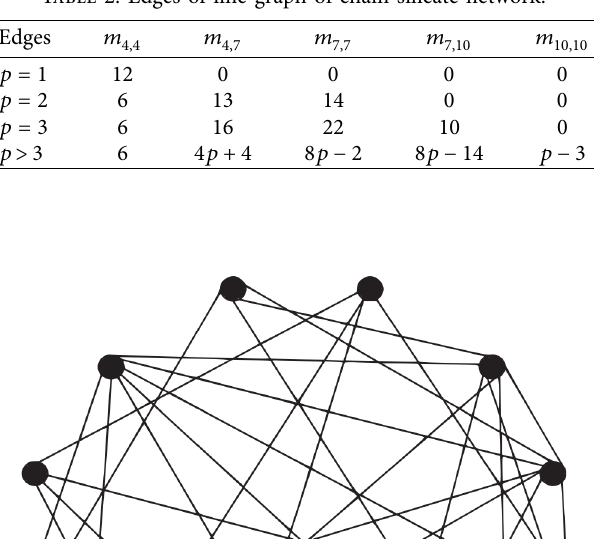
Figure 1: Chain silicate network CS ( 1 ) and its line graph L ( CS ( 1 )) (left to right). Table 2: Edges of line graph of chain silicate network.